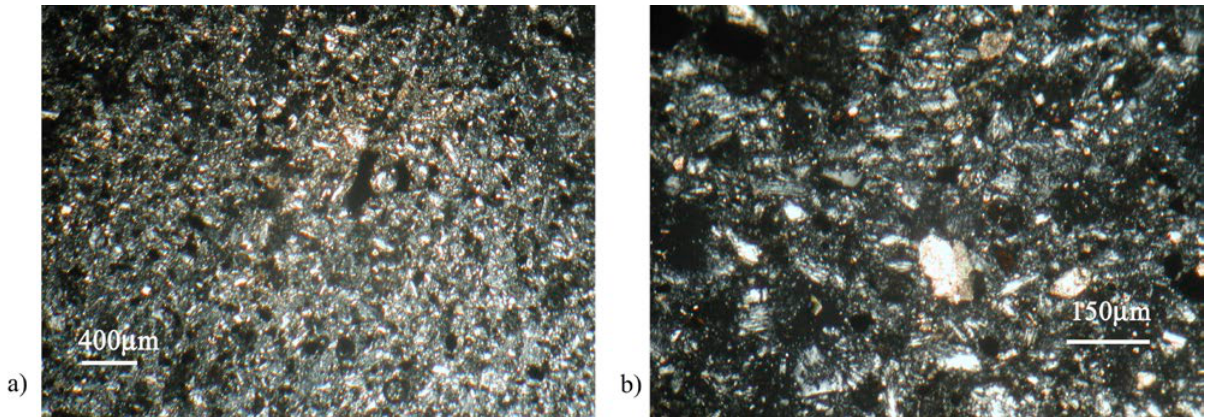
Figura 6. Product L, sample 18 – a) Cross nicols image: general view of the plaster with gypsum in the binder and in the aggregate; b) Cross nicols image: particular of the binder of dark colour, constituted by gypsum; it is visible aggregate, with prevalence of gypsum and trace of quartz and calcite (in colour brown in the top of